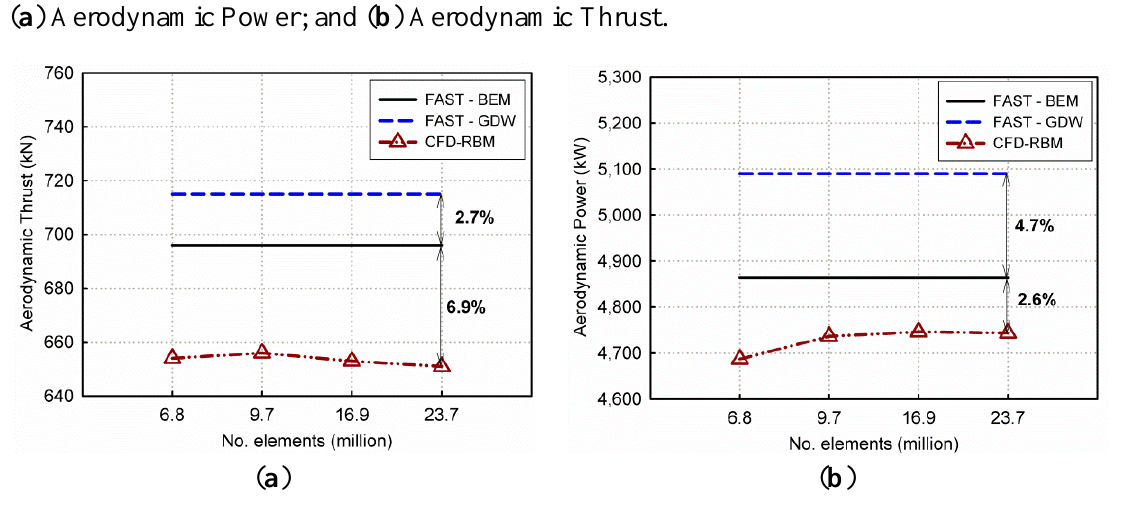
Figure 6. Mesh convergence study for the grid size on NREL 5-MW wind turbine